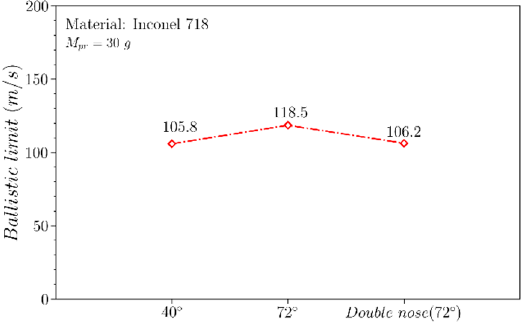
Figure 9. Ballistic limit vs. the projectile geometry nose-angle.